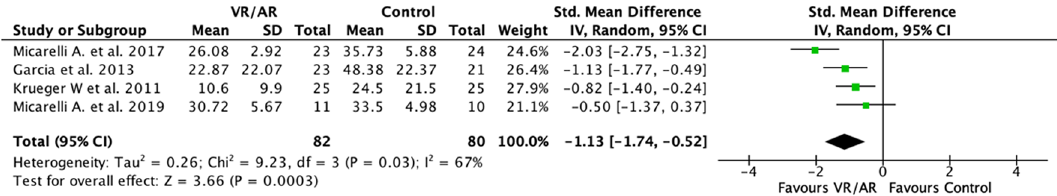
Figure 2. Post-intervention symptom index score (DHI) meta-analysis. SMD between VR/AR and control vestibular rehabilitation is listed. DHI dizziness handicap index, SMD standardized mean difference, VR virtual reality, AR augmented